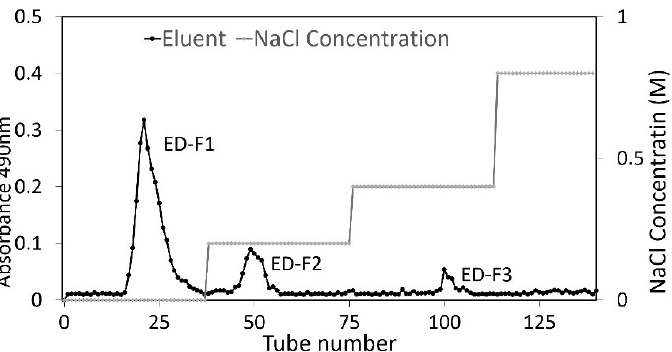
Figure 1. E. denticulatum low molecular weight oligosaccharide fractions obtained through anion exchange chromatography (DEAE ‐ Sepharose ® Fast Flow).